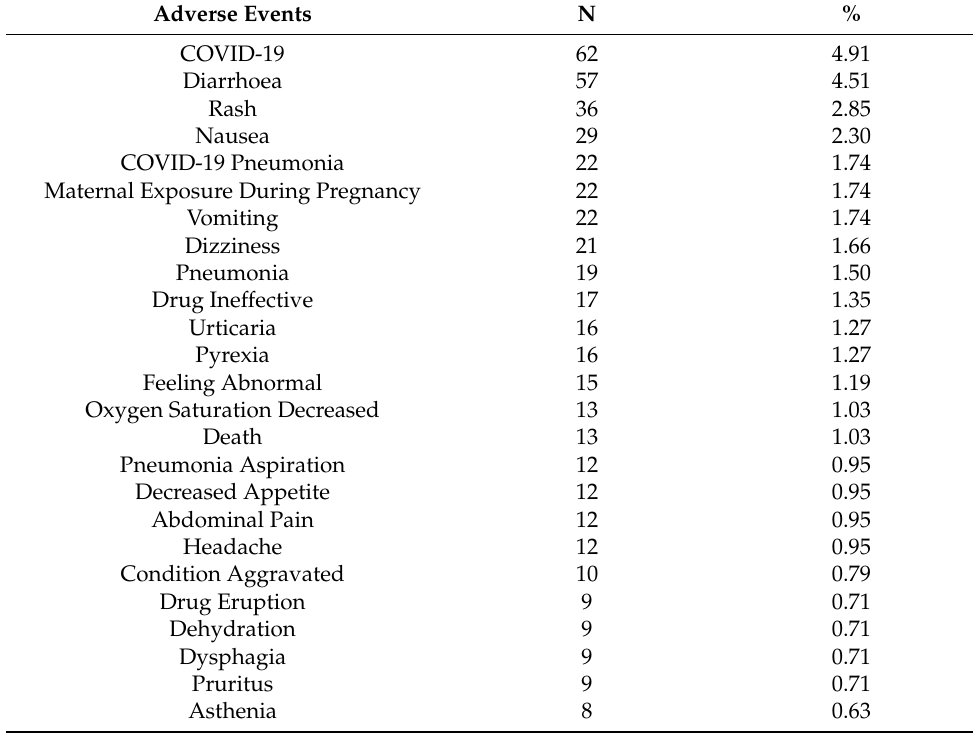
Table 2. Most reported adverse events in